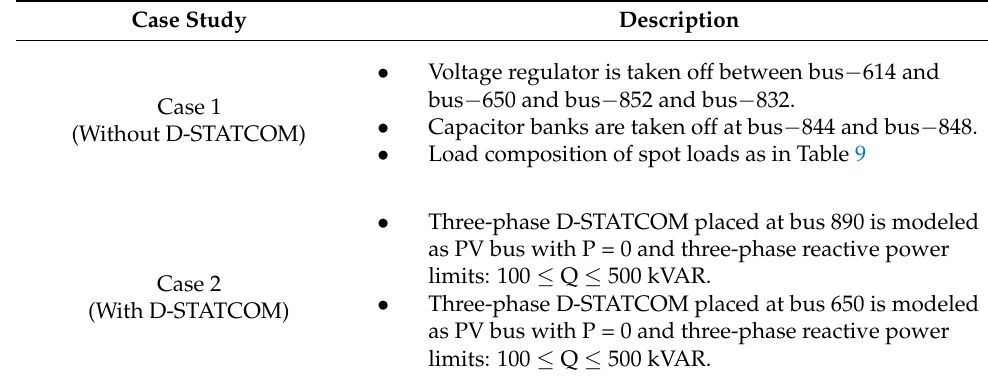
Table 11. Case studies on IEEE − 34 bus URDN.